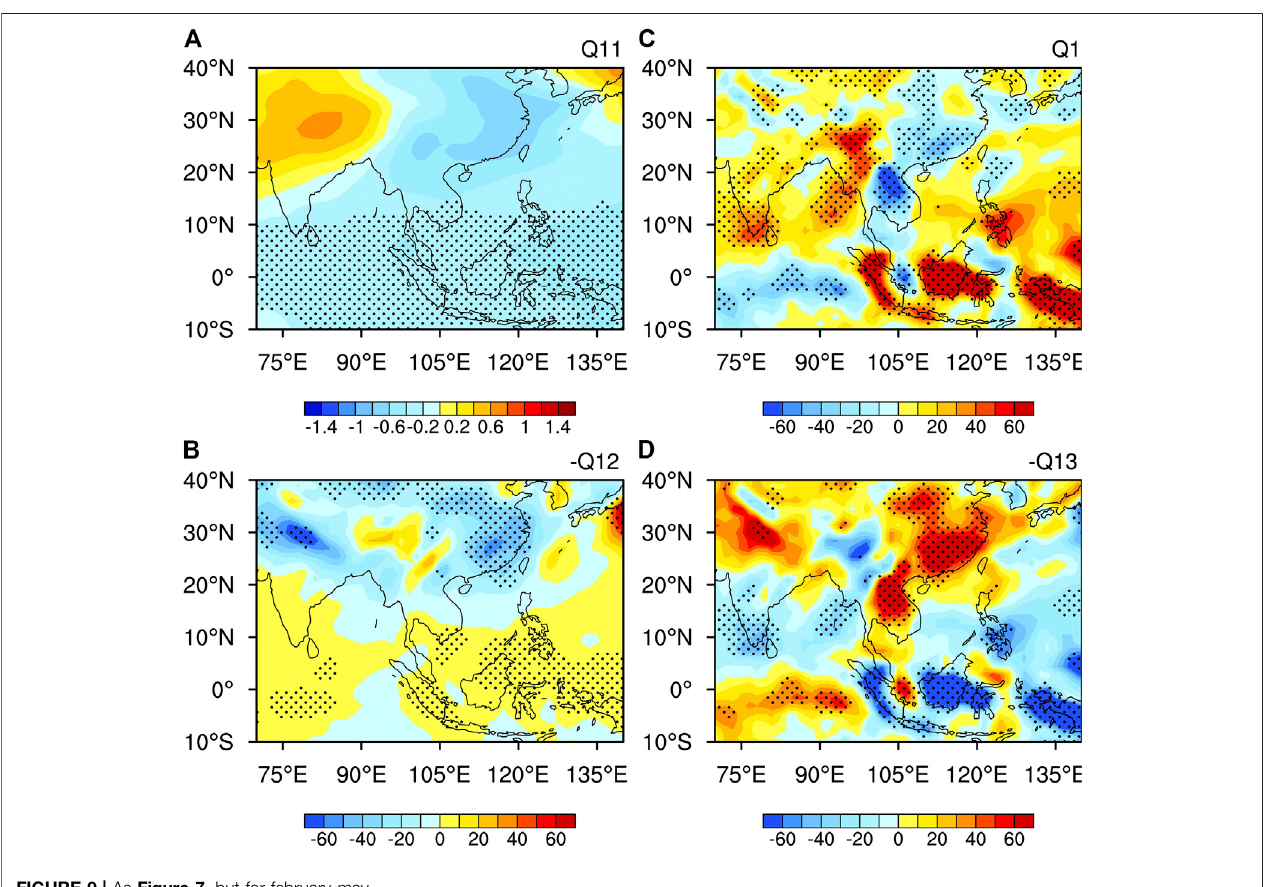
FIGURE 9 | As Figure 7 , but for february-may.